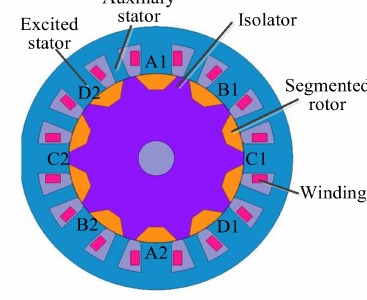
Figure 7. Machine topology of the 16/10 SRM with segmented rotors and excited and auxiliary stators.